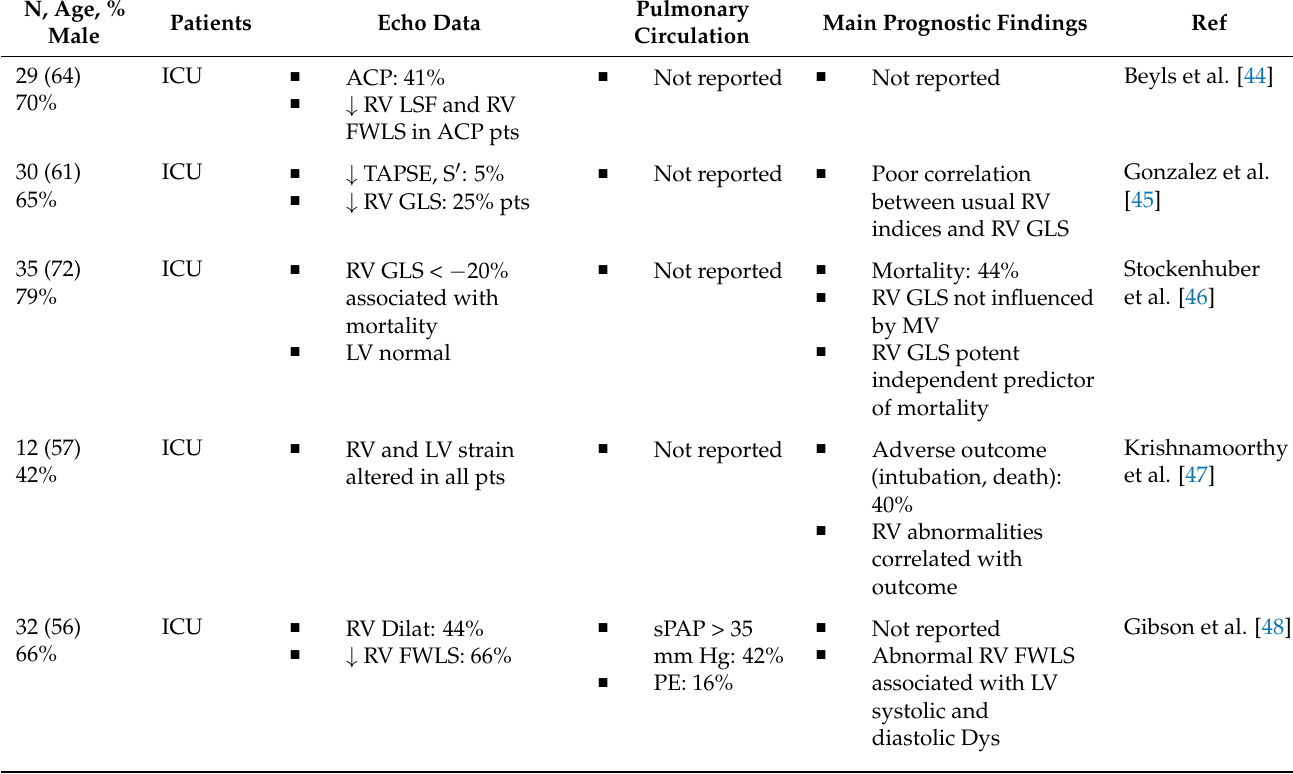
Table 2. Two-dimensional speckle tracking echocardiographic studies in COVID-19 patients.